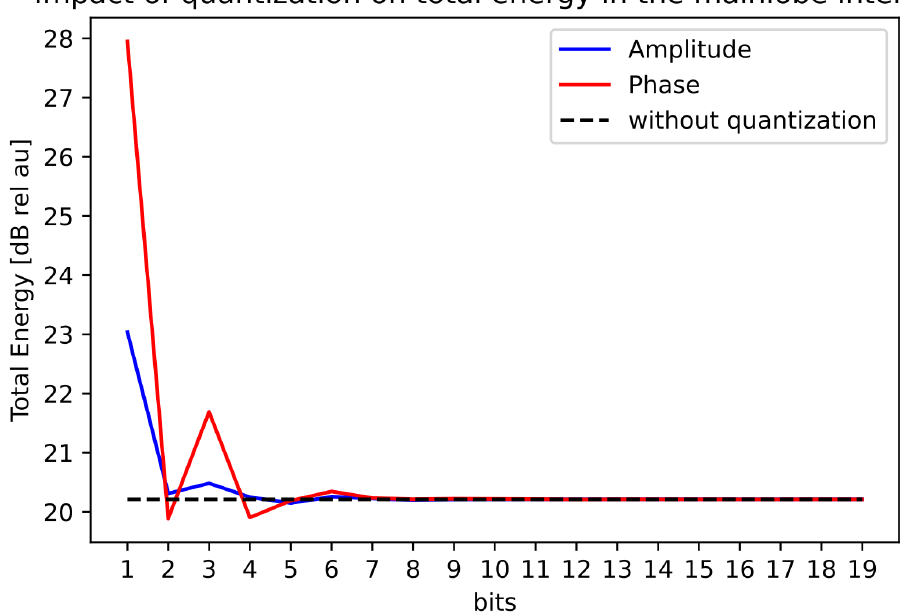
Figure 10. Quantization effect on the total energy in the main lobe interval for the ramped beampat- tern mask with BW = 70 ◦